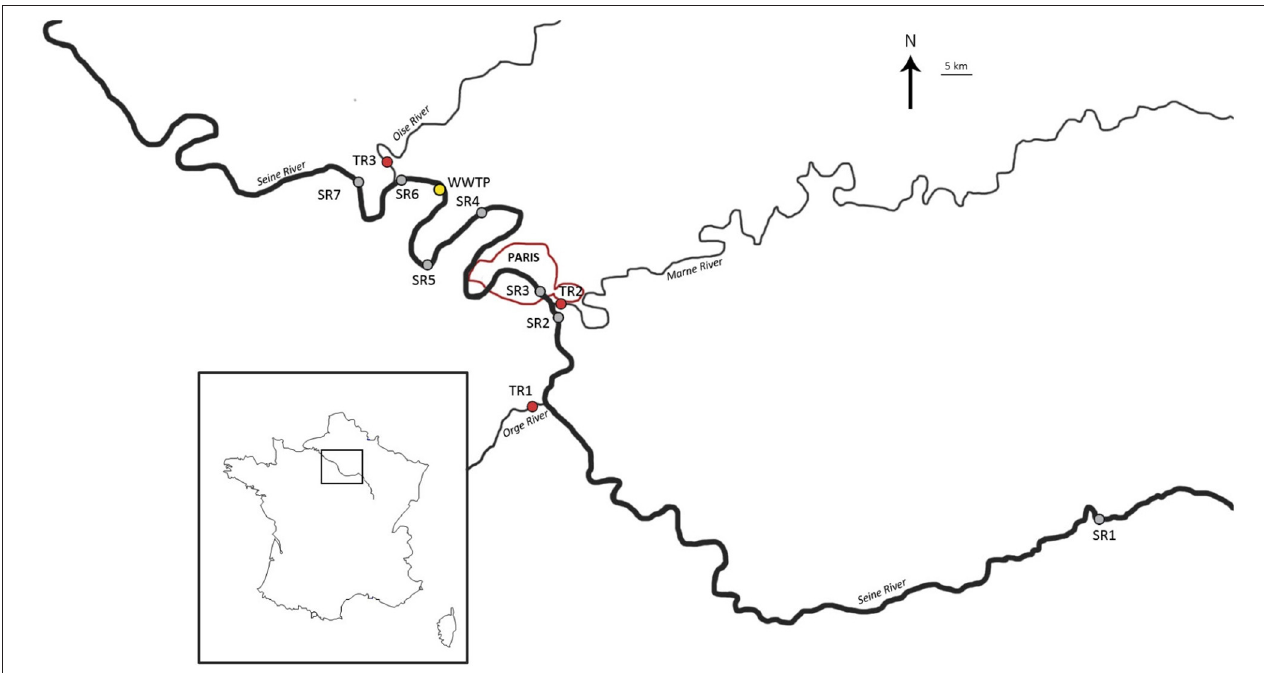
FIGURE 1 | Field investigation on the Seine River starting from Marnay-sur-Seine (SR1) through Paris city (SR3) to Triel-sur-Seine (SR7), where WWTP refers to a wastewater treatment plant (this point was not sampled). Also sampled were the three tributaries of the Seine River: Orge River (TR1), Marne River (TR2), and Oise River